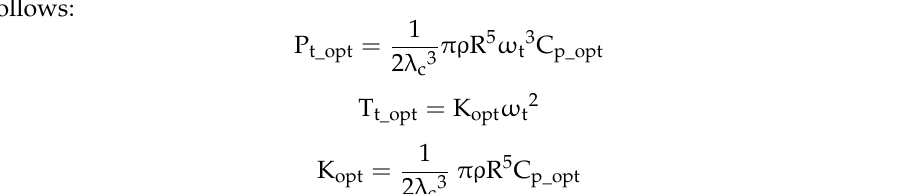
Figure 8. Classification of MPPT Techniques.